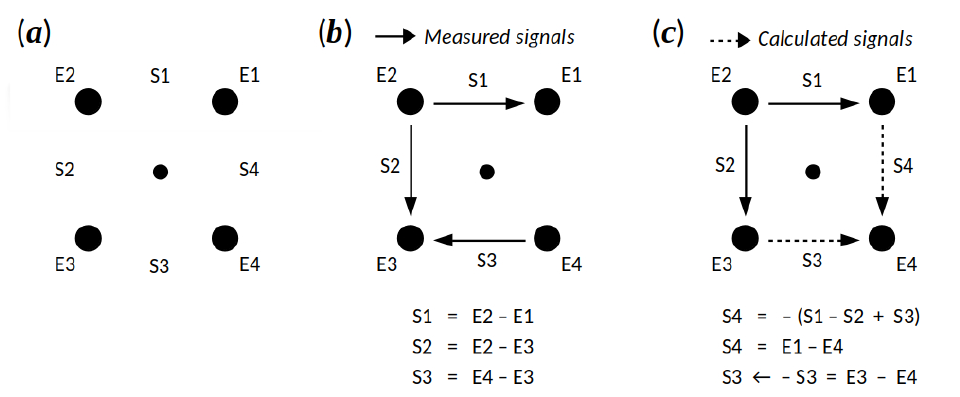
Figure 3. ( a ) Positions of the electrodes measuring the EHG potentials on the abdominal surface; ( b ) measured EHG signals of the records of the Term–Preterm EHG DataSet with Tocogram (TPEHGT DS) and their orientations. ( c ) Calculated and consistently oriented EHG